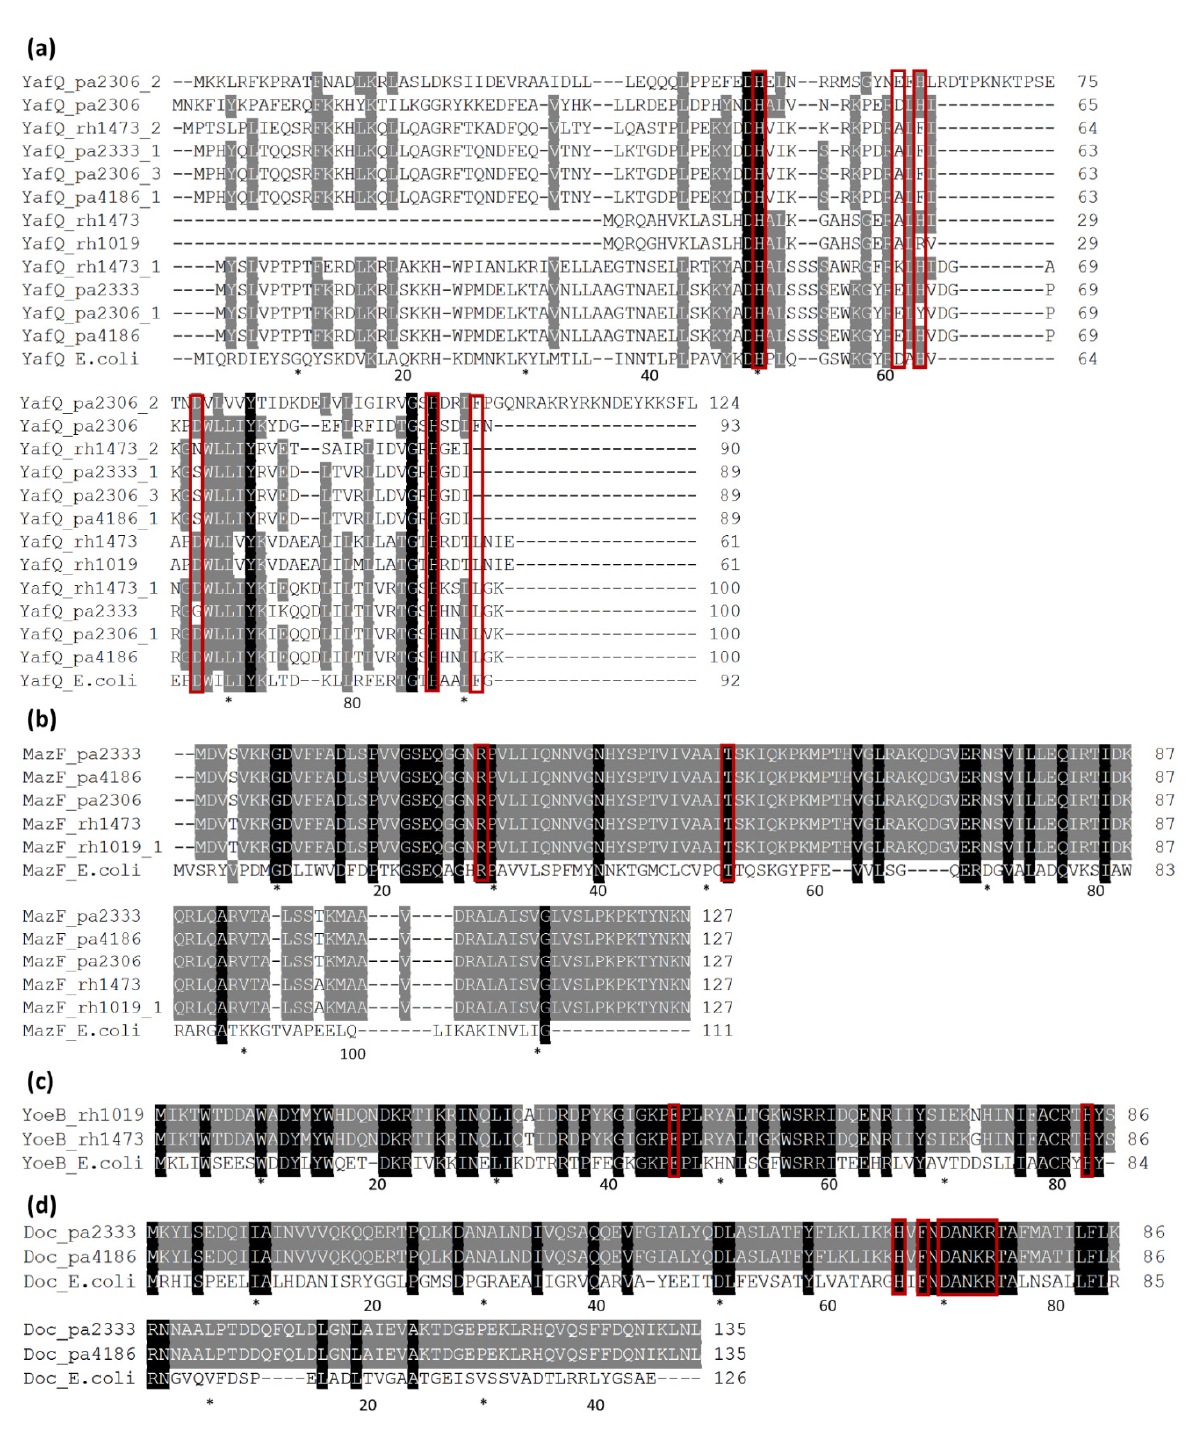
Figure 6. Multiple sequence alignments of all the toxins identified in Lacticaseibacillus strains compared with E. coli homologous sequences. ( a ) YafQ proteins, E.coli sequence accession number HAM8829092; ( b ) MazF proteins, E.coli sequence accession number WP_000254738; ( c ) YoeB proteins, E.coli sequence accession number WP_112934640; ( d ) Doc proteins, E.coli sequence accession number WP_001216045. The catalytic residues identified in E. coli proteins are boxed in red and the numbering of E. coli residues is reported. Abbreviations prior to strain names are: pa: L. paracasei , rh: L. rhamnosus . * 10 bp intervals along with the sequence length